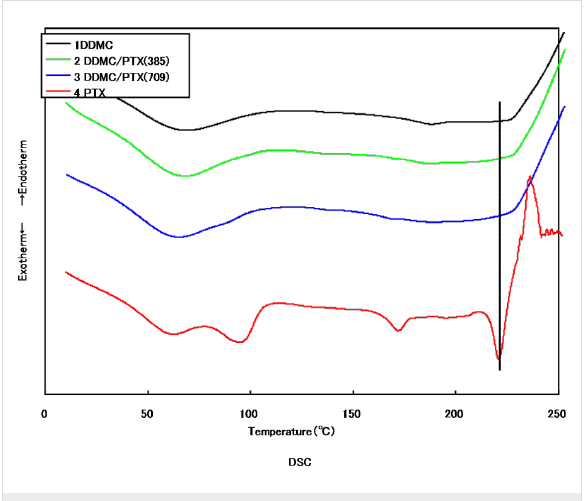
Figure 2: Differential scanning calorimetry (DSC) with DDMC–pacli- taxel complex and paclitaxel: (1) DDMC, (2) DDMC/PTX